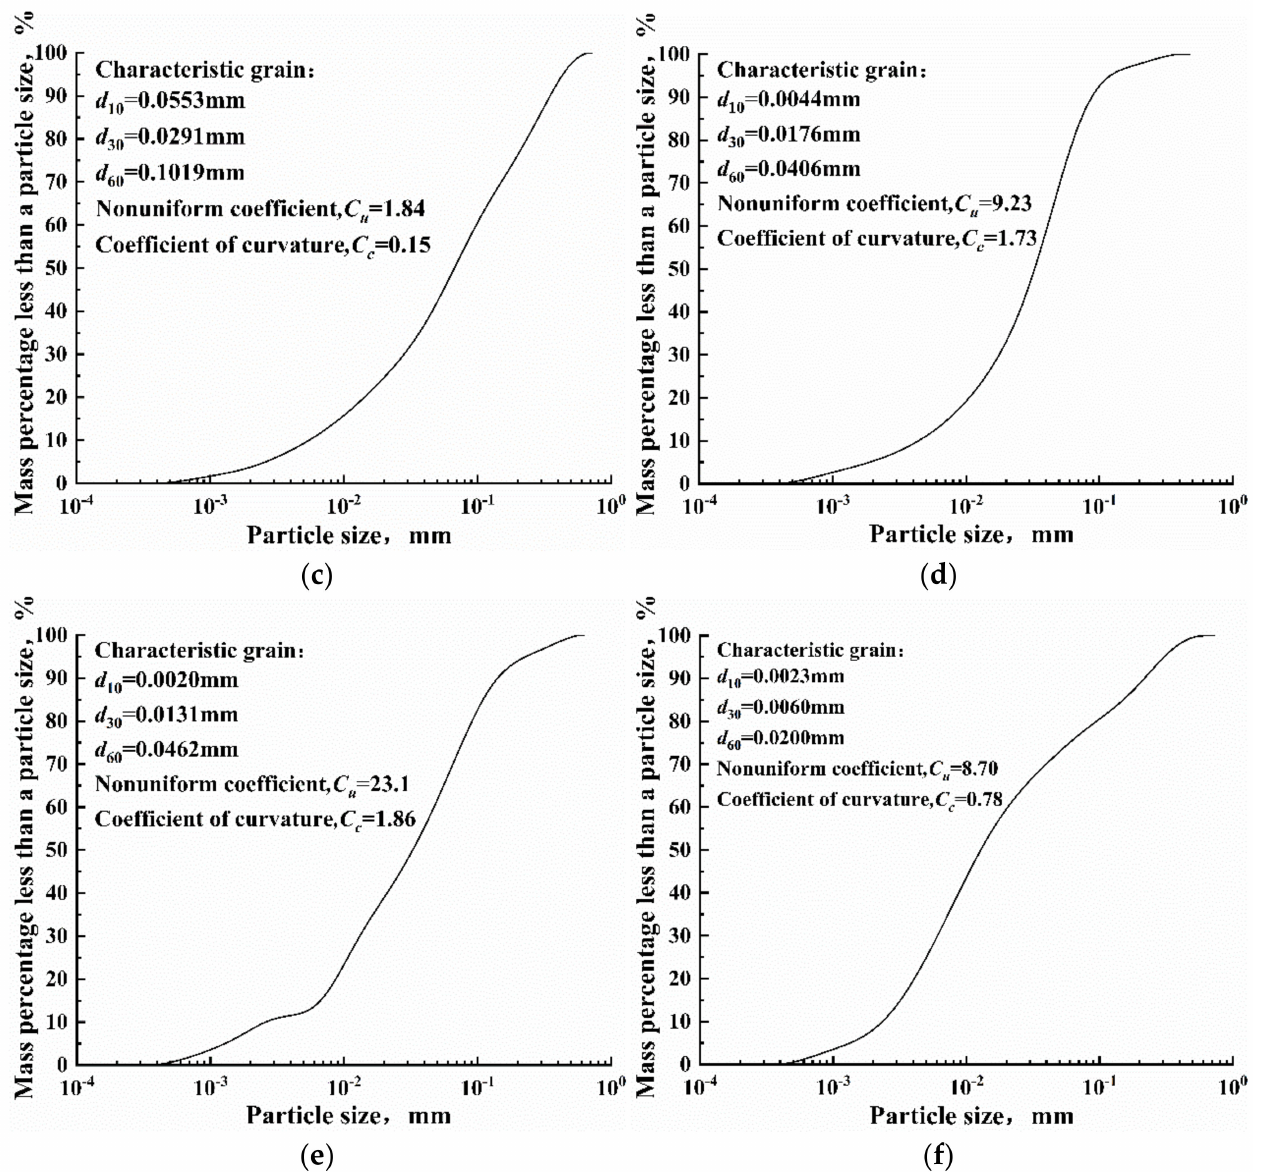
Figure 2. Semilogarithmic curve of particle gradation: ( a ) Lanzhou loess, ( b ) Songling soil, ( c ) Tahe soil, ( d ) Harbin clay, ( e ) loam, ( f ) Genhe red